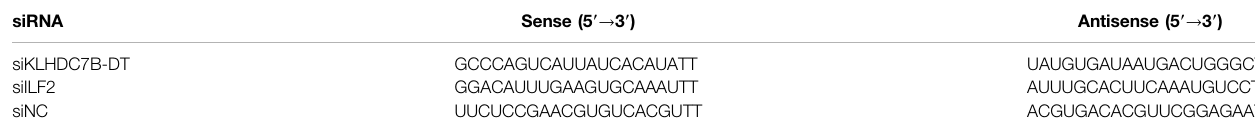
TABLE 1 | Oligonucleotide sequences.